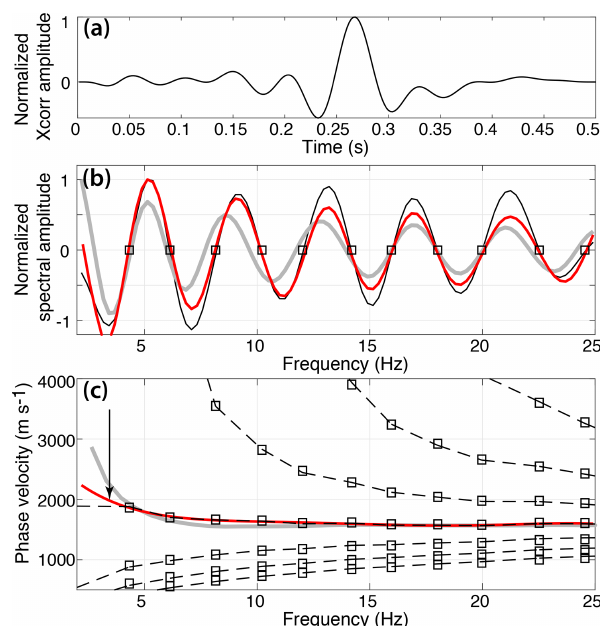
Figure B3. Computation of Rayleigh wave phase velocity using Aki’s spectral method. (a) Symmetric icequake cross-correlation function obtained for one receiver pair in Glacier d’Argentière, with stations 450m apart. (b) The real part of the spectrum of (a) is in black, and associated zero crossings are marked by squares. The gray line indicates the real part of the spectrum associated with an a priori phase velocity dispersion curve which serves as a starting model for the least-square fit (in red) of the observations. (c) Corre- sponding phase velocities estimated by zero crossings (black dashed lines) and least-square fit (red). The prior dispersion curve used for the Bessel fit is plotted in gray. The black arrow indicates the min- imum frequency above which we can trust the velocity measure- ments and corresponds to approximately one